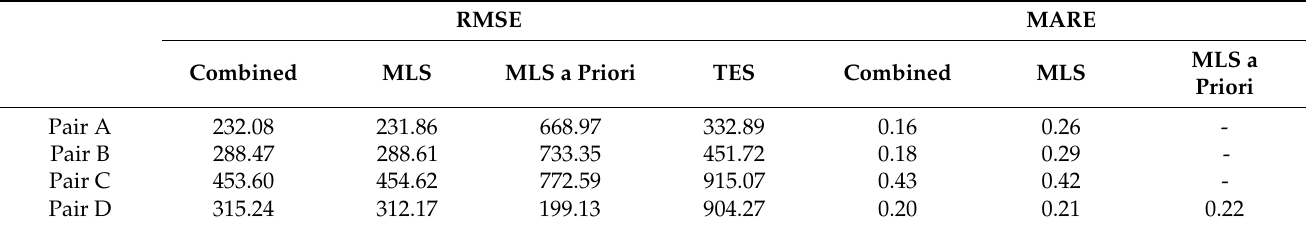
Table 3. RMSEs and MAREs of ozone profiles from satellites and ozonesonde. Unit: ppbv (RMSE), unitless